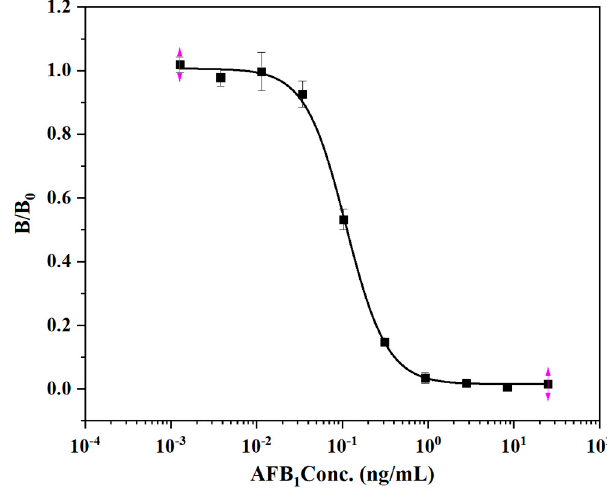
Figure 6. Competitive standard curve of monoclonal antibody against AFB 1 on enzyme label plate.